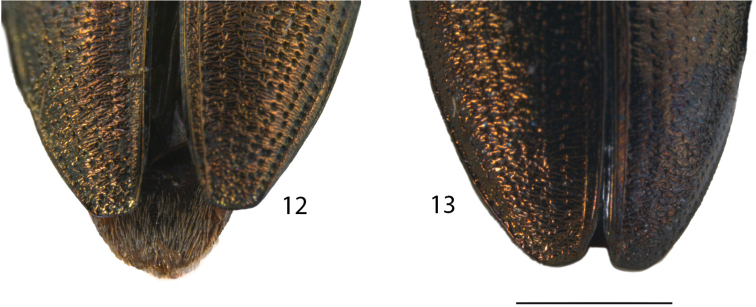
Elytral Apex. 12Donaciaclavareaui13D.fukiensis. Scale bar: 1 mm.